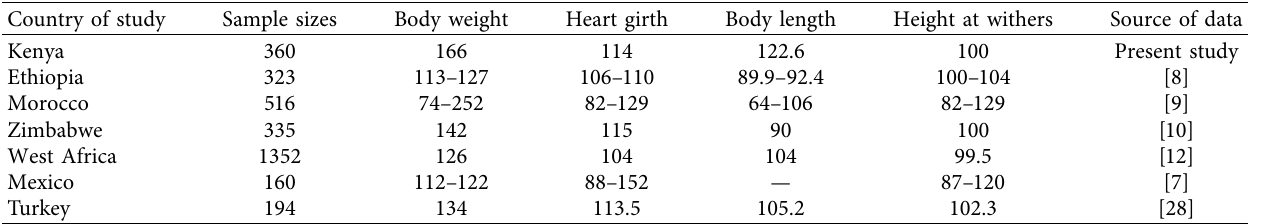
∗ Formula used to estimate the body weight for young and adult Table 2: Descriptive measures of body measurements for working donkeys sampled from the central highlands in Kenya. Parameter Heart girth Height at withers Donkey weight Table 3: Comparison of some morphometric measurements on donkeys from central Kenya and different parts of the world. Country of study